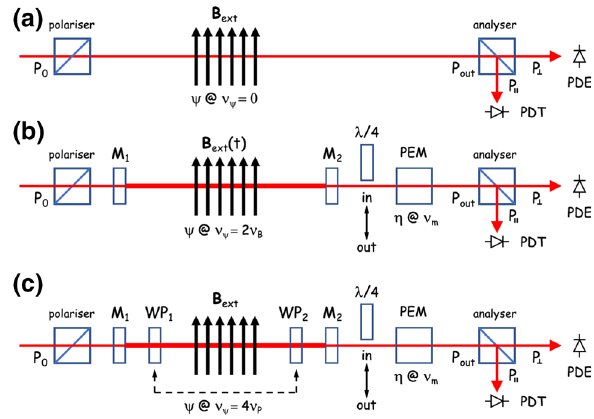
Fig. 1 Polarimetricschemes:PDE:extinctionphotodiode;PDT:trans- mission photodiode; M 1 , 2 : cavity mirrors; λ/ 4: quarter-wave plate; PEM: photo-elastic modulator; WP 1 , 2 : rotating half-wave plates. The quarter-wave plate is inserted when rotation measurements are per-